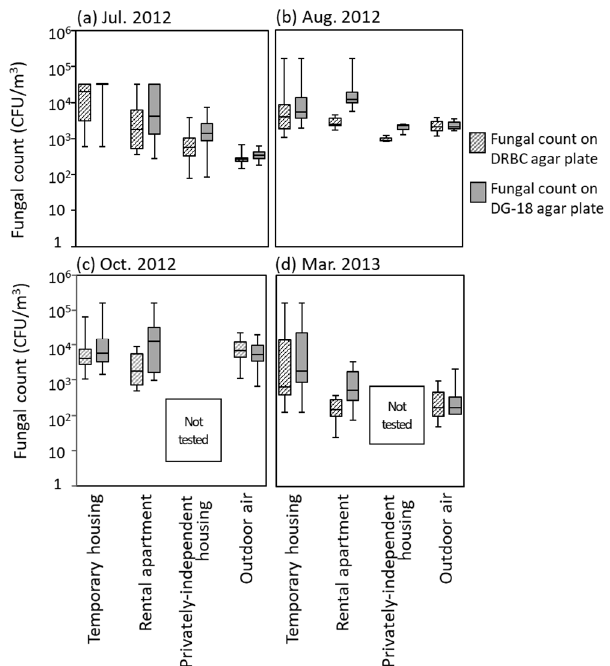
Figure 4. Comparison of fungal counts in various types of housing. We collected samples four times a year in 52 homes for covering four seasons; ( a ) rainy season in July 2012, ( b ) summer in August 2012, ( c ) autumn in October 2012, and ( d ) winter in March 2012. Boxplots were formed in each data-set of fungal counts on DRBC agar plates or them on DG-18 agar plates.